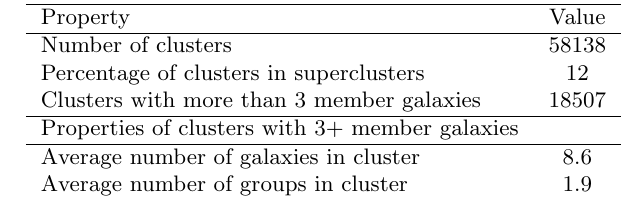
Table 1. Properties of the cluster